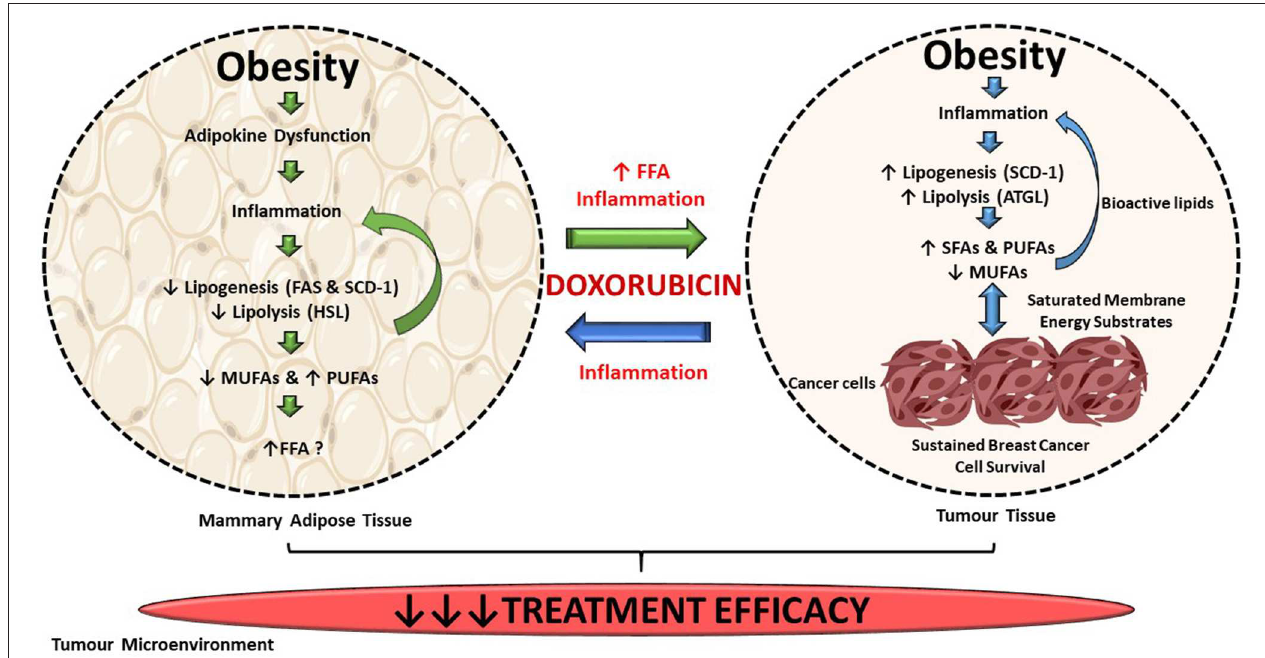
FIGURE 13 | Summary of findings. DIO selectively supresses de novo FA synthesis and lipolysis in mammary adipose tissue, but increased lipogenesis and lipolysis in tumor tissue. Exogenous dietary lipids can alter the energy metabolism of triple-negative breast cancer tumors in this current in vivo model. Alterations in FAs composition in both mammary adipose and tumor tissue could be a mechanism by which FAs composition can be altered in response to DIO within the tumor microenvironment and thereby contributing to the decreased efficacy of breast cancer treatment agent within our current model.